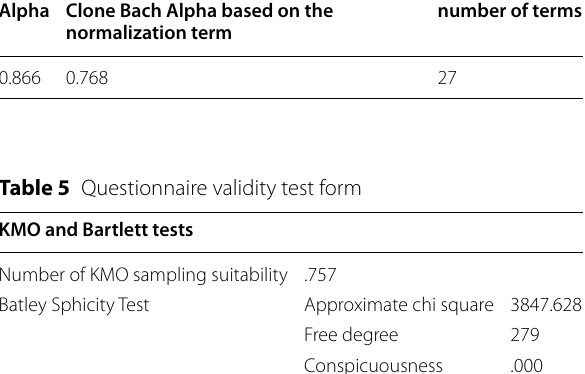
Table 4 Questionnaire reliability statistics table Alpha Clone Bach Alpha based on the normalization term